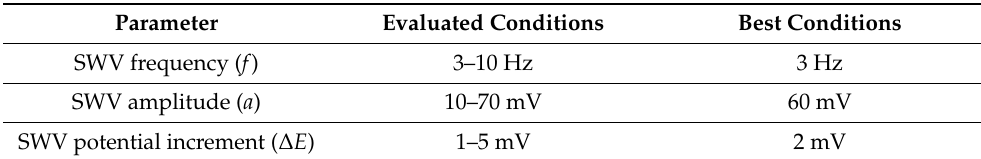
Table 1. Optimization of experimental conditions for paraquat detection using the square-wave voltammetry (SWV) technique.